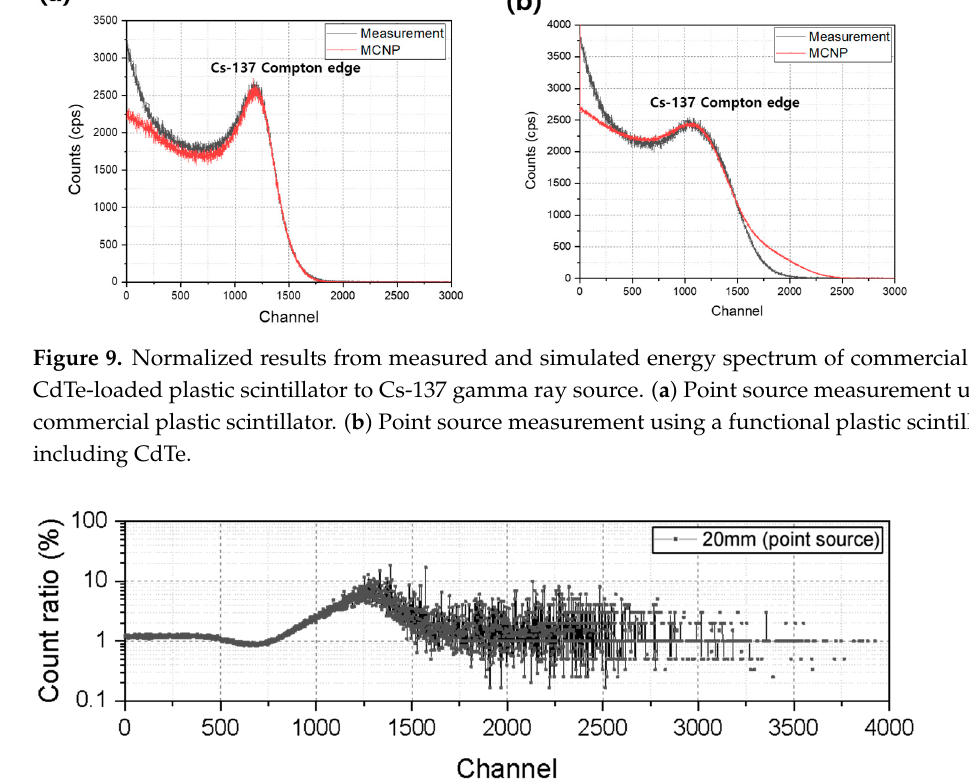
Table 4. Progress of CdTe-enabled optical materials.